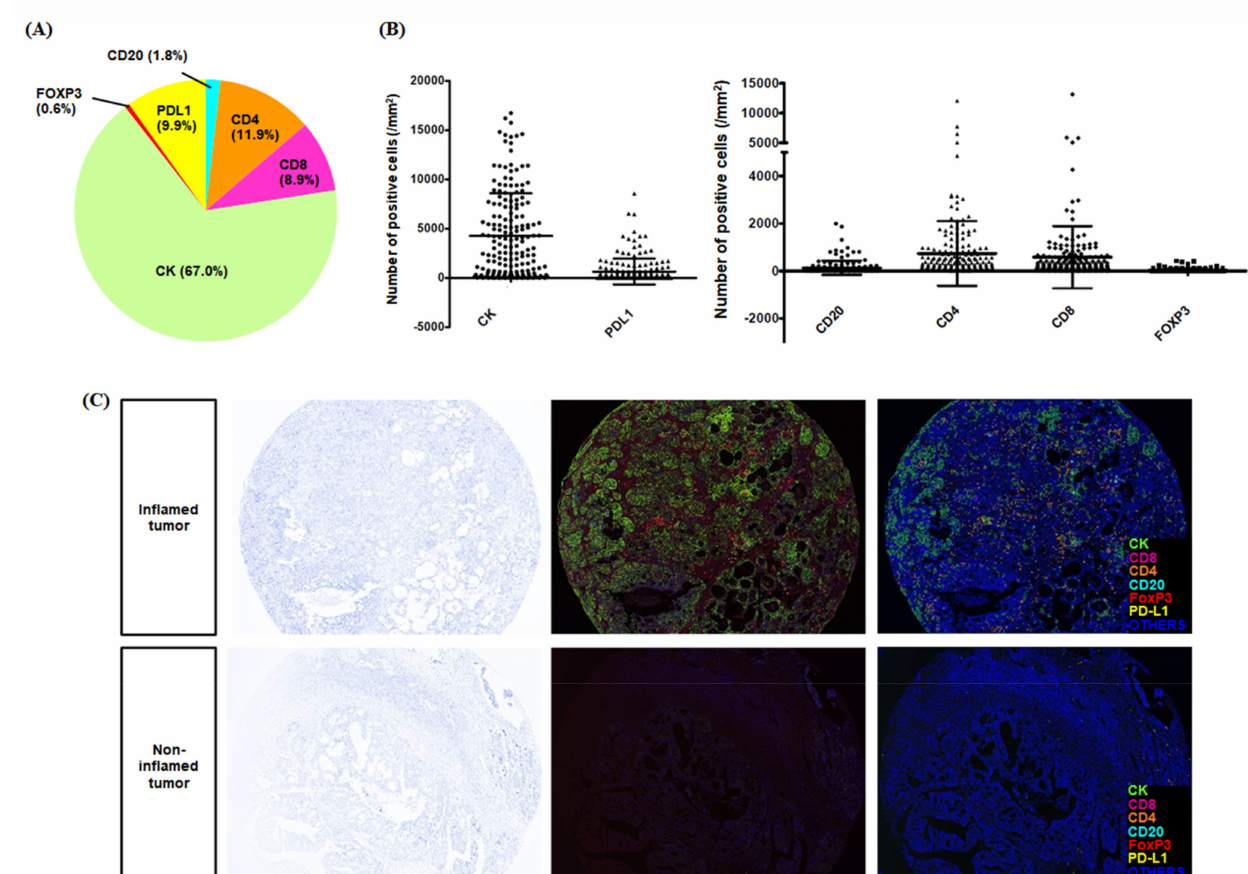
Figure 2. The diverse immune cellular densities and the quantitative values of each immune marker. We obtained the simultaneous staining result of multiple biomarkers, including CK, CD8, CD4, CD20, FoxP3, and PD-L1. After simultaneous staining, automated phenotyping was possible, and the quantitative analysis for positive cellular densities of positive cells was conducted. ( A ) Among six markers, the positive proportion was high in orders of CD4, PD-L1, CD8, CD20, and FoxP3, excluding CK. ( B ) The quantitative value of each marker was shown individually different. ( C ) The inflamed tumors were clearly indicated in the phenotyping view of Opal staining, as shown in the middle